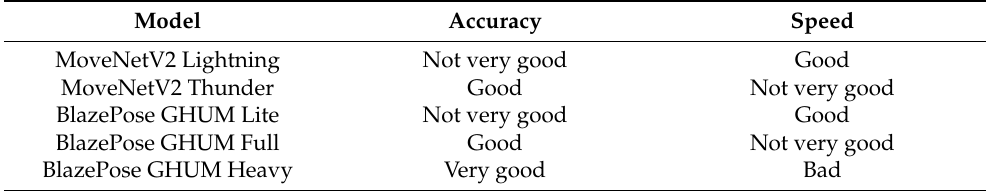
Table 3. Performance comparison among proposed models. Model Accuracy